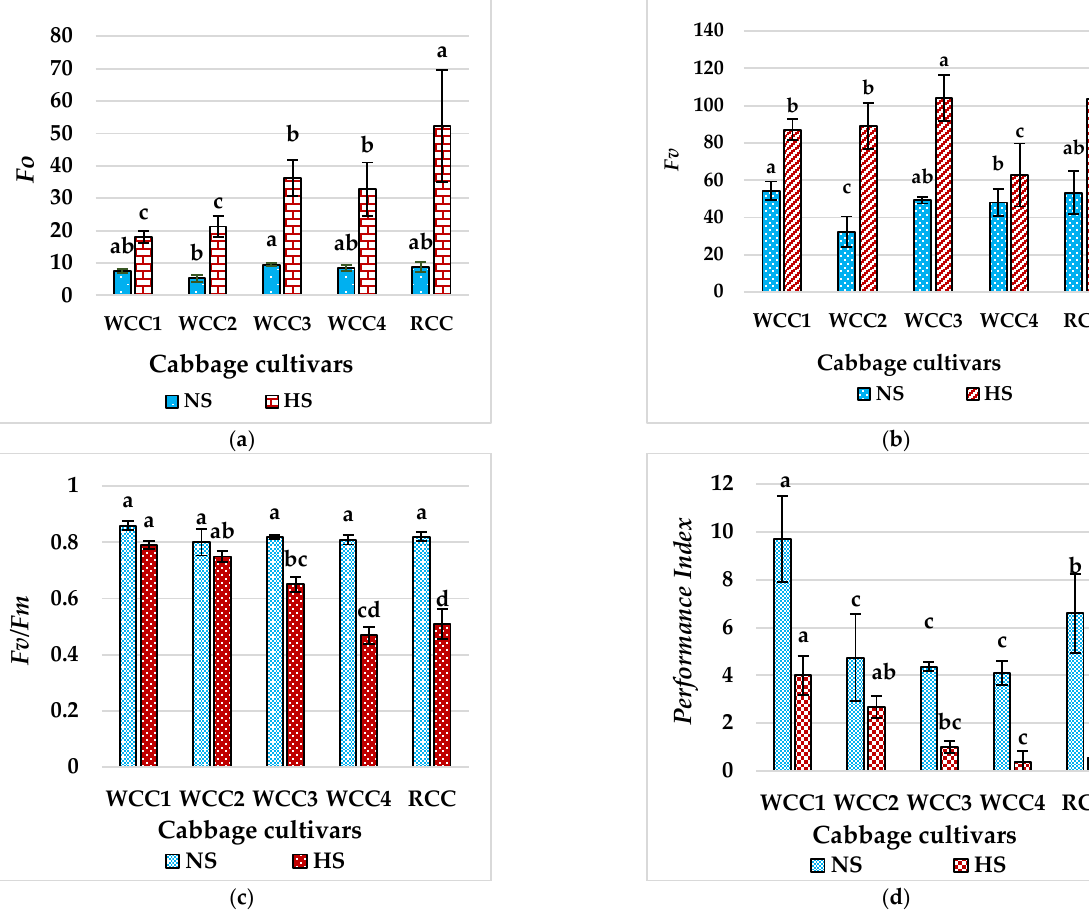
Figure 4. Mean phenotypic expression of chlorophyll fluorescence under HS. ( a ) Comparison of minimum fluorescence ( Fo ) in five cabbage cultivars, ( b ) comparison of variable fluorescence ( Fv ) in five cabbage cultivars, ( c ) comparison of the Fv/Fm ratios in five cabbage cultivars measured and ( d ) comparison of photosynthetic performance index ( PI ABS ) in five cabbage cultivars. All measurements were performed under HS (at 42 ◦ C; for 5h) and NS (25 ◦ C) conditions. Bars denote the mean of at least 5 measurements ± SE. Mean values within each cultivar with different letters are significantly different based on Tukey’s HSD test at p <